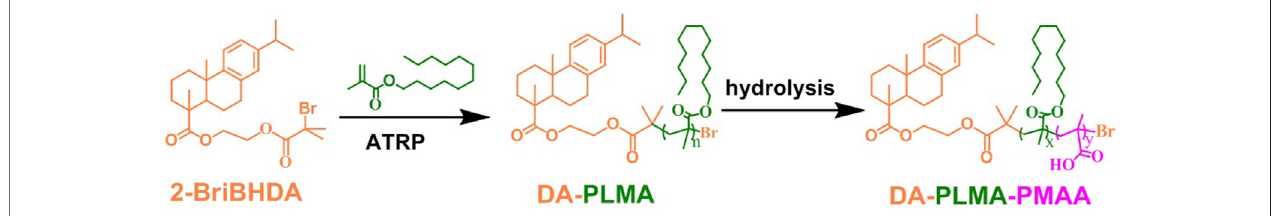
FIGURE 1 | Schematic illustration of synthesis of DA-PLMA from DA-based initiators, and partial hydrolysis of DA-PLMA to prepare DA-PLMA-PMAA.